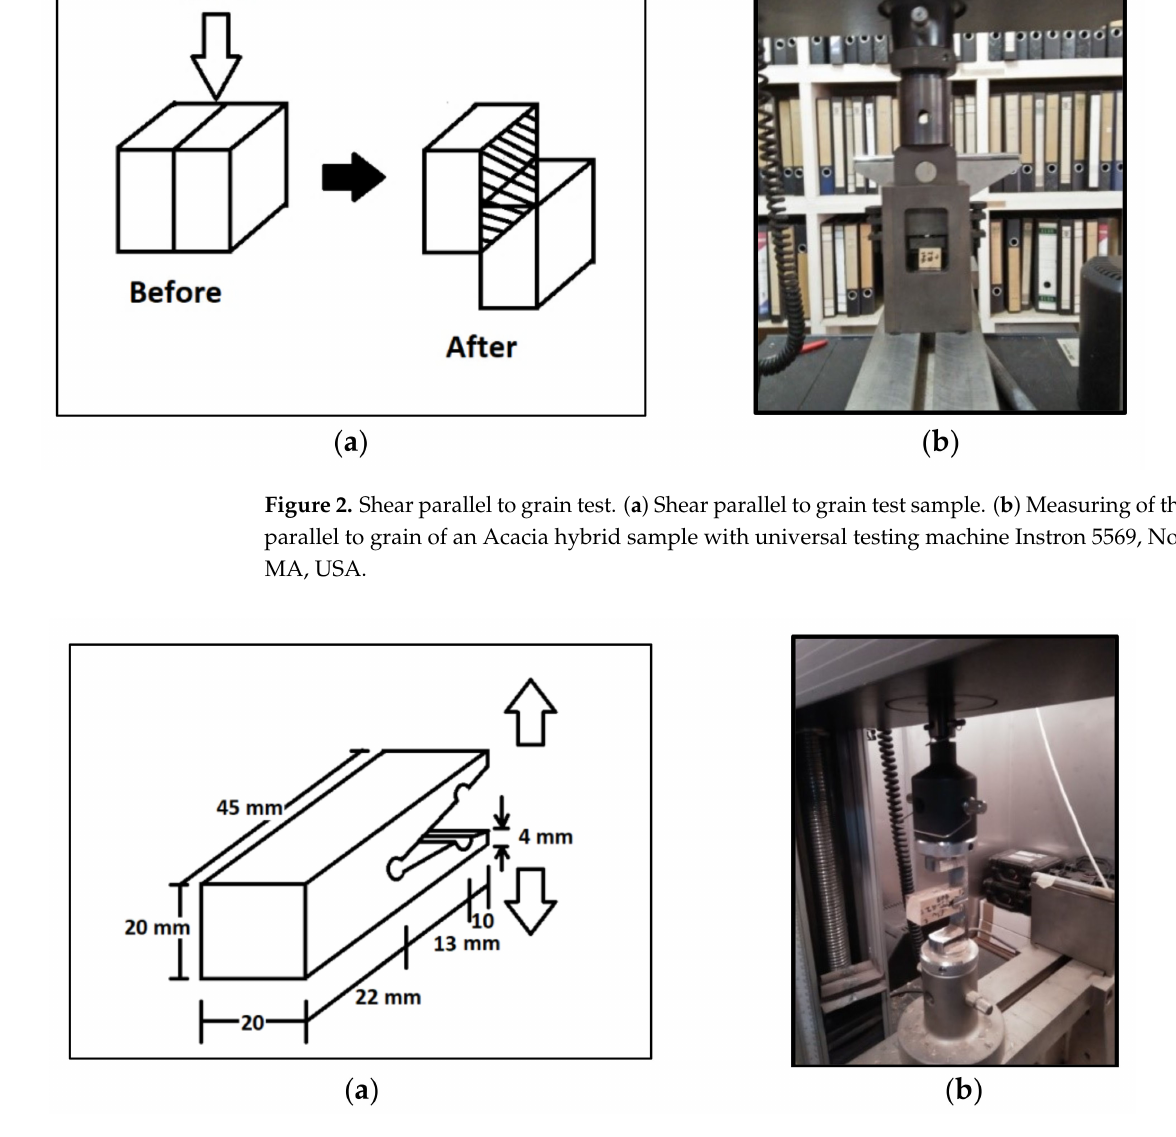
Figure 3. Cleavage test. ( a ) Cleavage test sample. ( b ) Measuring of the cleavage of an Acacia hybrid sample with universal testing machine Instron 5569, Norwood, MA,